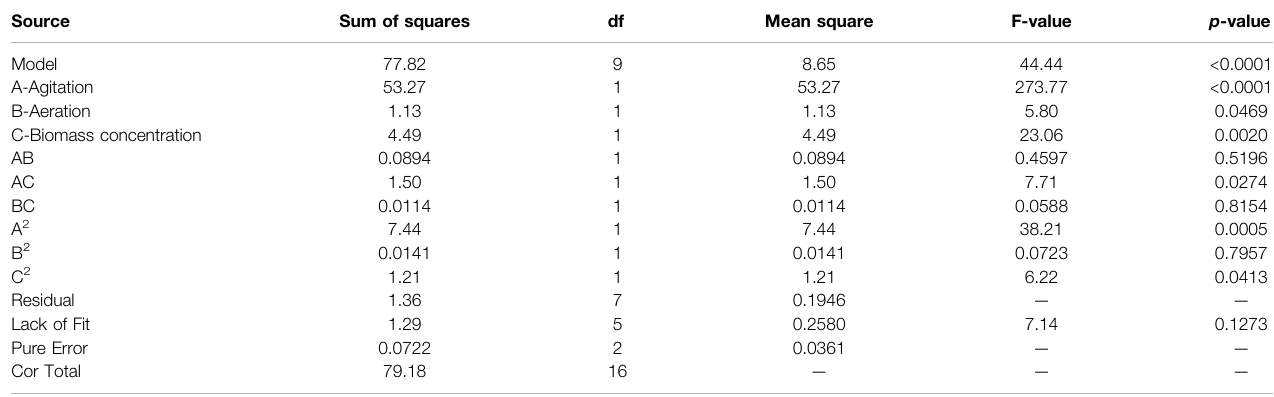
TABLE 3 | Analysis of variance (ANOVA) for all model terms.